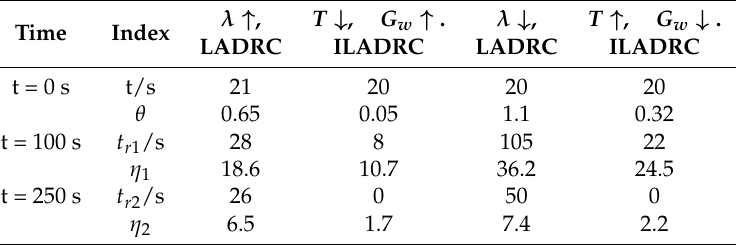
Table 3. Control performance